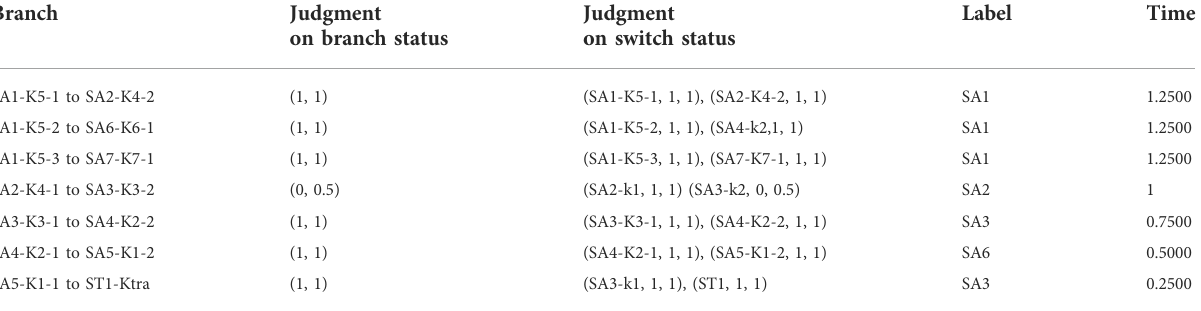
TABLE 10 Topology table of SA1 in Round 5 with measurement